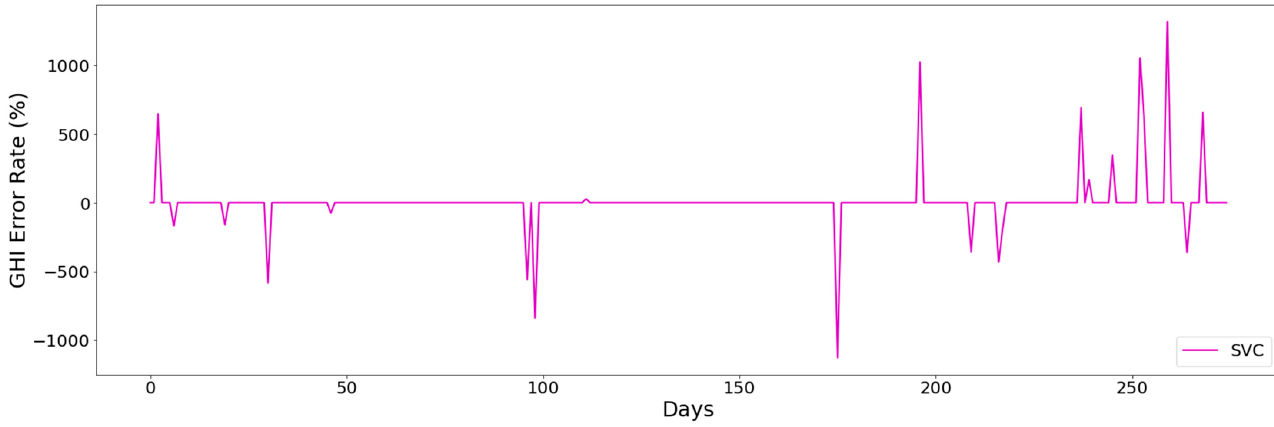
Table 4. Comparison of the statistical metrics for GHI with existing methods.